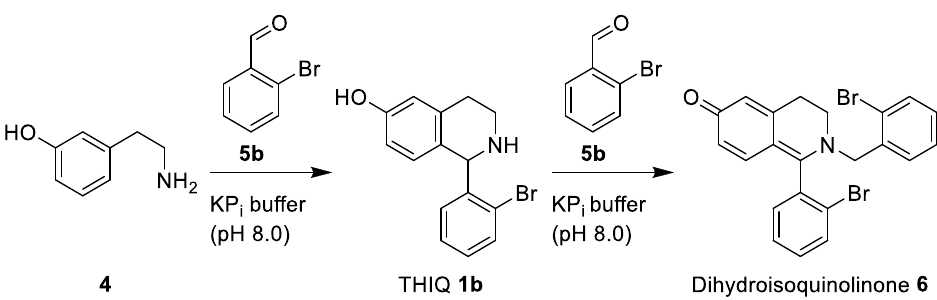
Scheme 6. Side reaction of the phosphate salt-mediated Pictet–Spengler reaction towards the by-product dihydroisoquinolinone 6 under alkaline conditions.